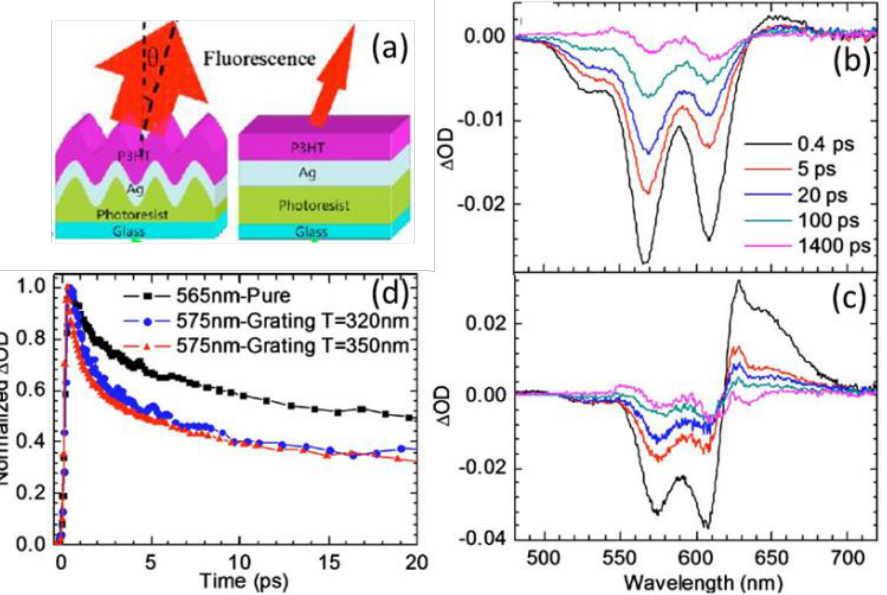
Figure 22. ( a ) Schematic of the fabricated samples with the structure of glass. TA spectra recorded at 0.4, 5, 20, 100, and 1400 ps, respectively, of P3HT on a ( b ) flat Ag film and ( c ) Ag grating. ( d ) TA dynamics at one peak of the photobleaching spectrums [104]. Reprinted with permission from Ref. [104].